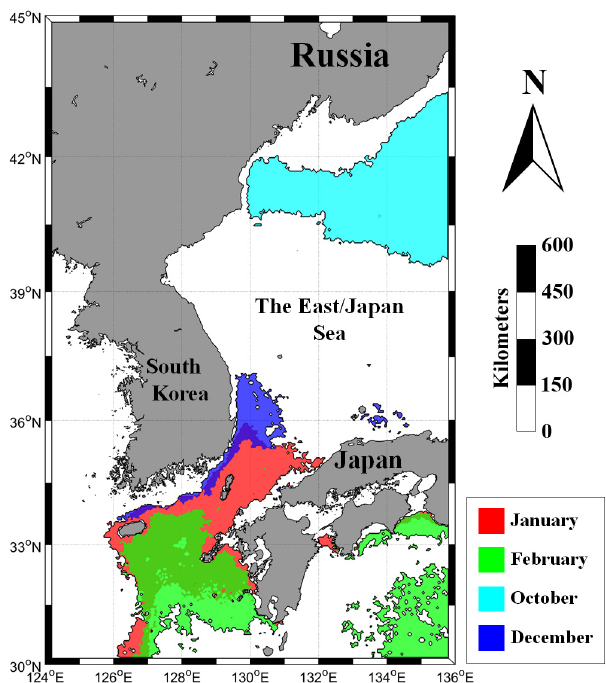
Figure 9. The HSI hotspots for the chub mackerel observed in the South Sea and the East/Japan Sea. In October, a large hotspot is found in the northern part of the East/Japan Sea. While the chub mackerel migrates northward of the East/Japan Sea, they usually branch off to several pathways [39]. Once they reach the northernmost part of their migration route during autumn, they start to move southward. It is possible for them to take several pathways while they migrate southward; however, the point where all the paths intersect is usually located near the Peter the Great Bay, Russia [38]. These various migration routes for the chub mackerel are well reflected in the wide hotspot that appeared in the north of the East/Japan Sea in October (Figure 9).